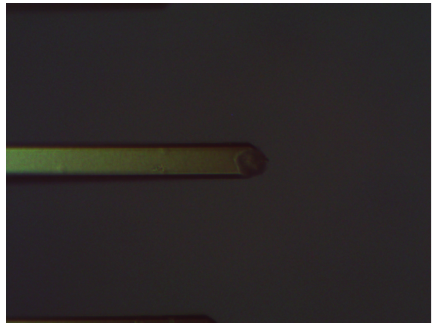
Figure 3: The photo of scheelite particle probe.